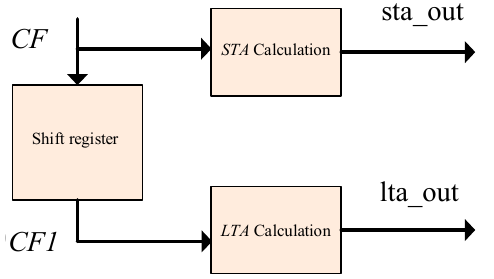
Figure 12. Long- and short-term average ( LTA / STA ) window calculation design.